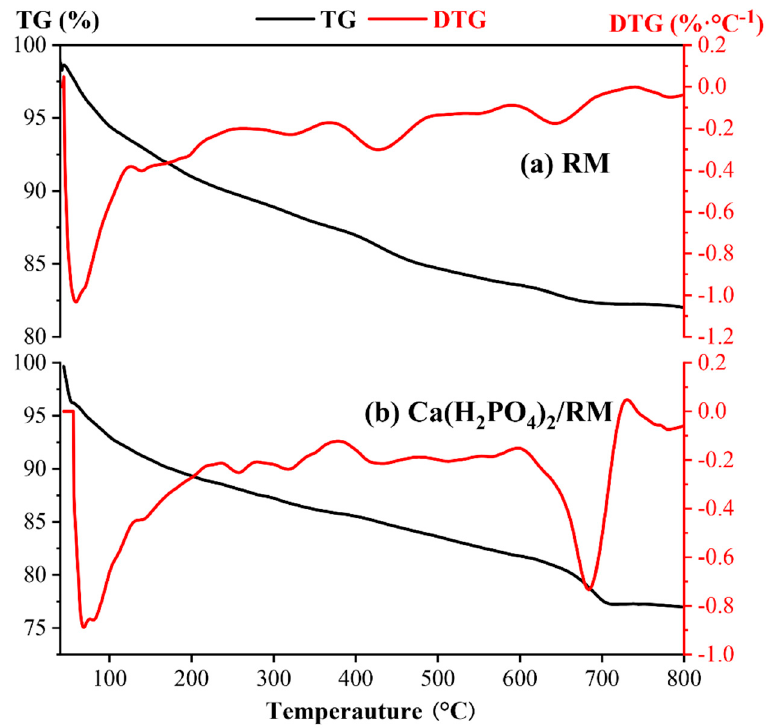
Figure 7. TG–DTG curves of red mud (RM) and Ca(H 2 PO 4 ) 2 /RM composite suppressants: ( a ) RM; ( b ) Ca(H 2 PO 4 ) 2 /RM.